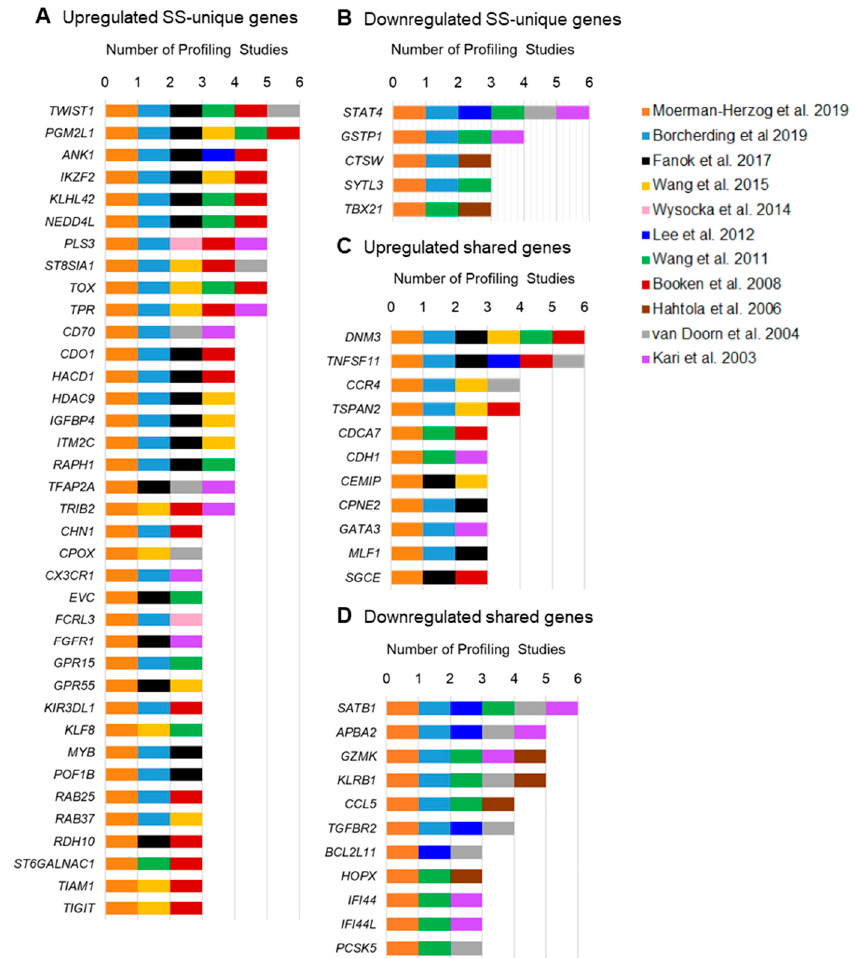
Figure 3. Di ff erentially identified genes from the meta-analysis of SS and L-HES are supported by prior SS studies. Gene expression results from Moerman-Herzog et al. were compared to prior transcriptomic profiling studies of SS (Table 3). Genes di ff erentially expressed from SS of prior studies were identified from the manuscript and supplementary data, using the significance threshold defined by each study. Gene symbols were updated using the Molecular Signatures database [79] and / or the GeneCards database [80]. Gene groups are defined by expression pattern, ( A ) upregulated SS-unique genes, ( B ) downregulated SS-unique genes, ( C ) upregulated shared genes, ( D ) downregulated shared genes. Only genes reported in at least three studies are shown. For each gene, studies that reported significant di ff erential expression for that gene are represented by color-coded boxes next to the gene symbol.